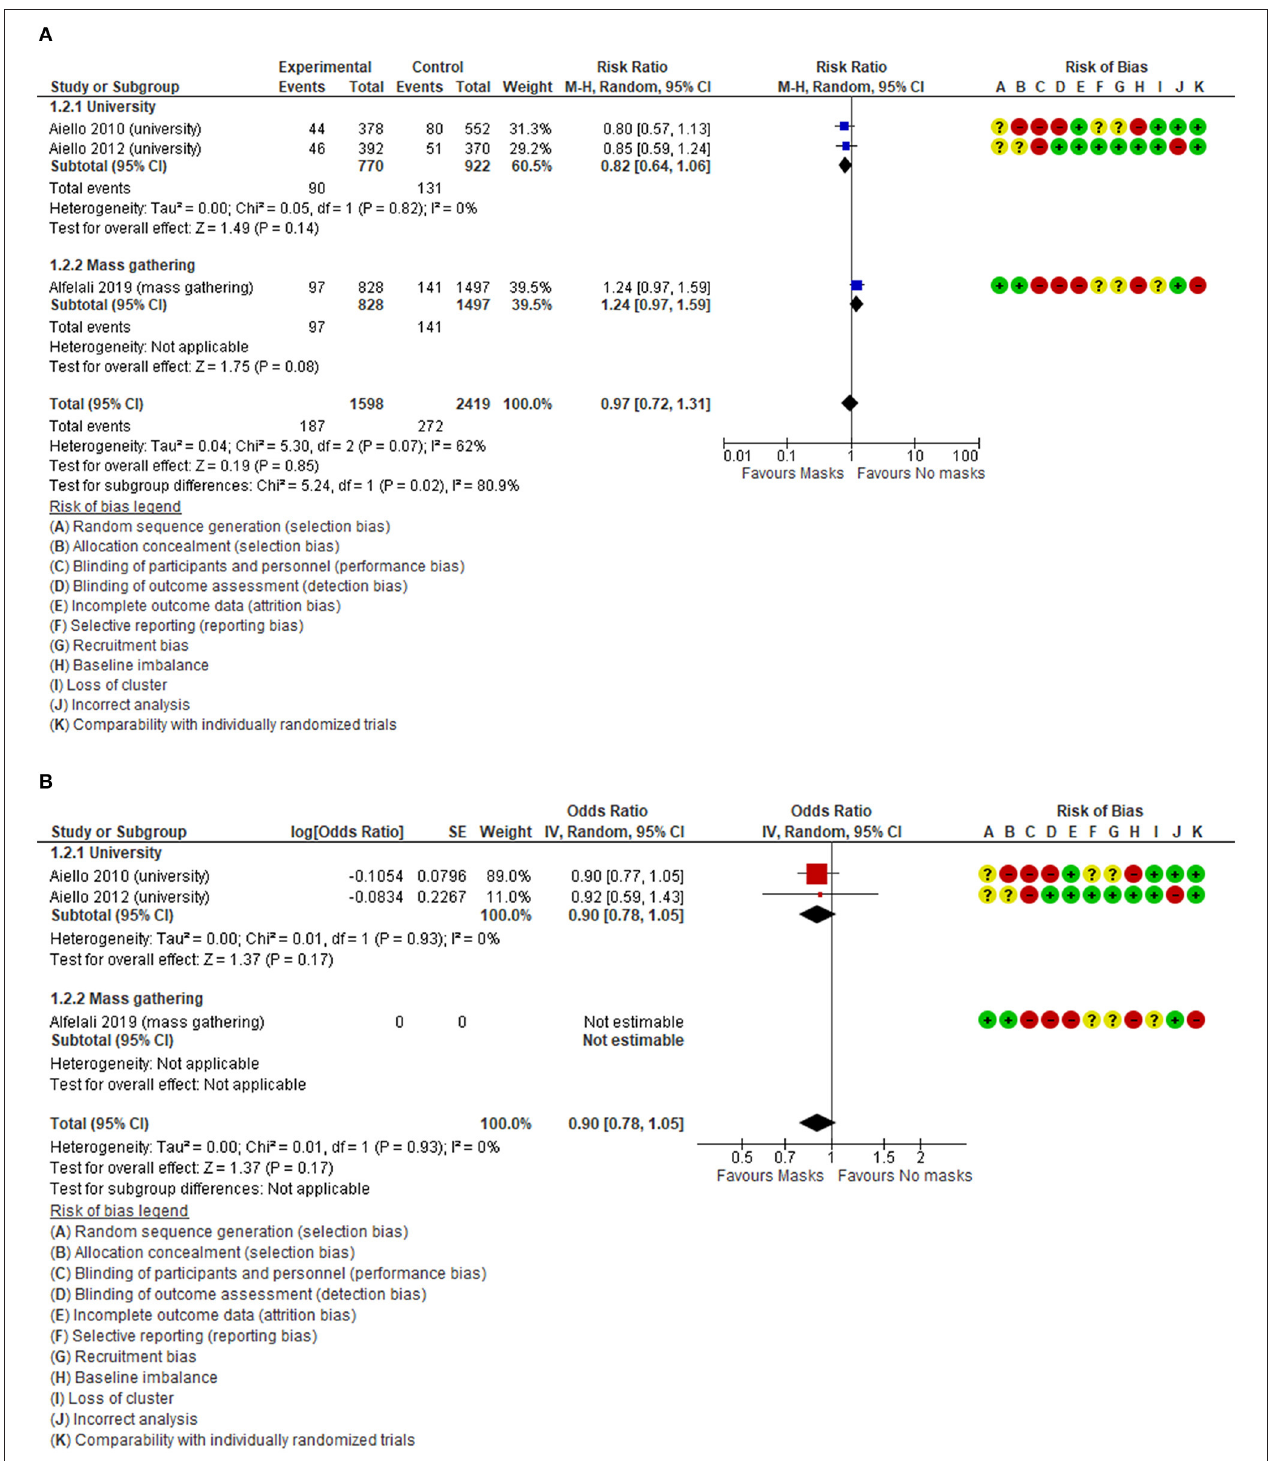
FIGURE 2 | (A) Unadjusted forest plot of respiratory infection rate and risk ratios in RCTs. (B) aORs forest plot of respiratory infection rate in